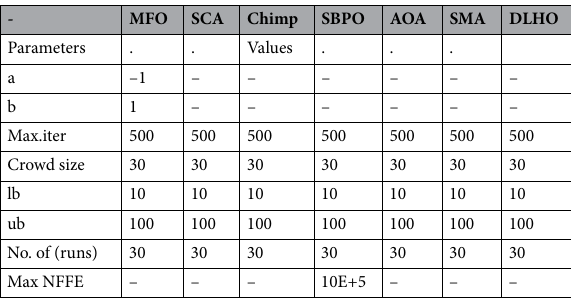
Table 1. Parameter settings for